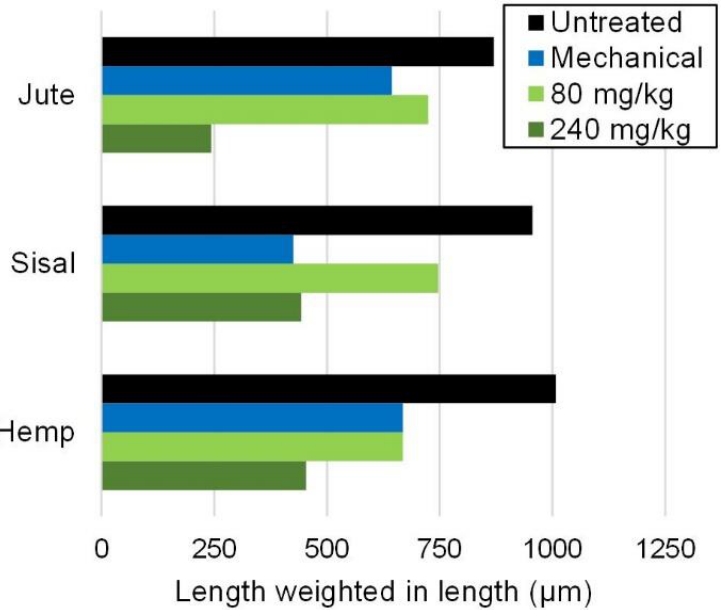
Figure 3. Effect of mechanical and enzymatic pretreatments on fiber length, expressed as the length- weighted mean. Table 1. Effects of mechanical and enzymatic pretreatments on key parameters of fiber morphology.